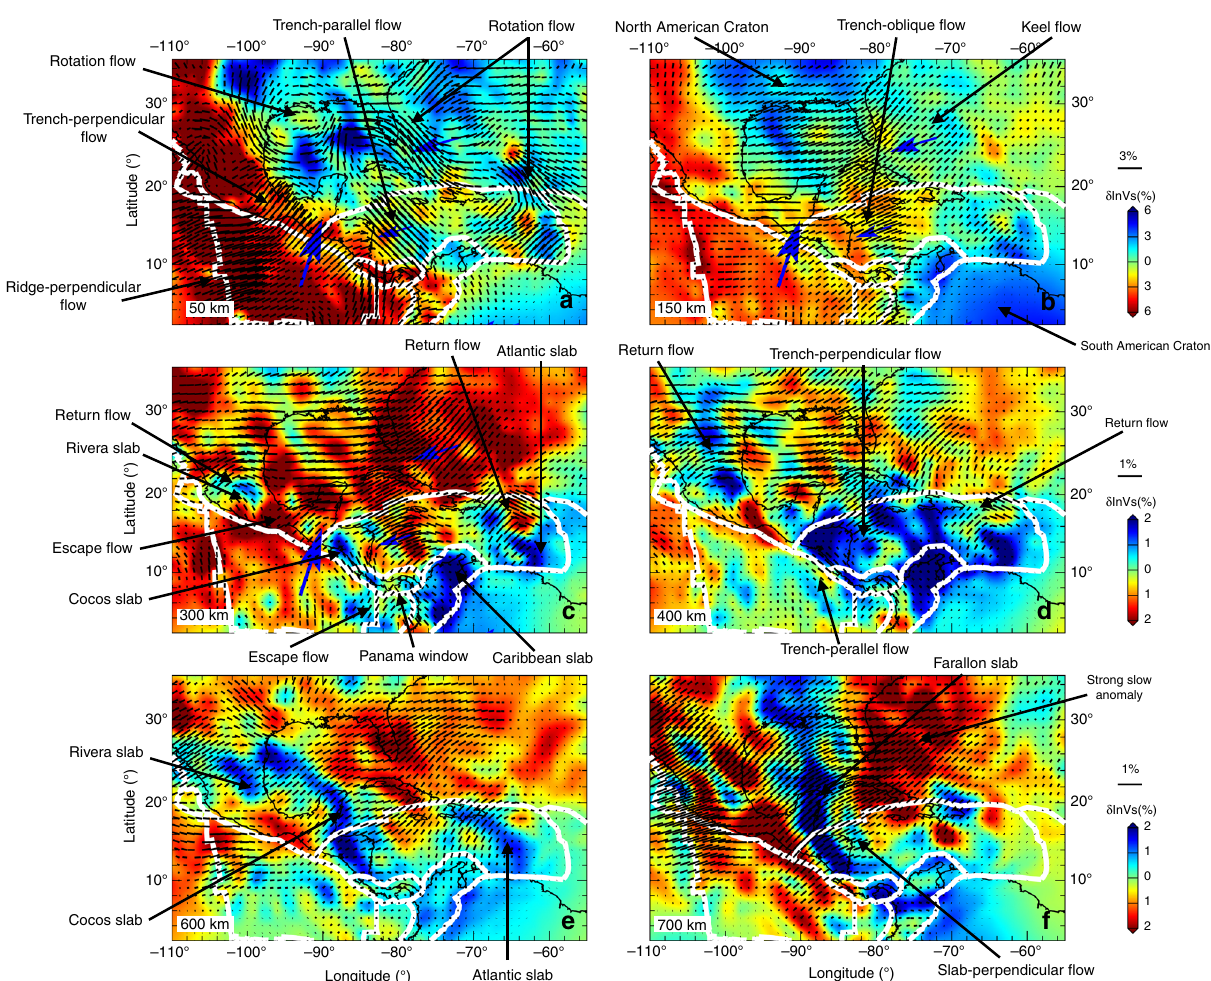
Fig. 5 Horizontal cross sections of relative perturbations in isotropic shear wavespeed and azimuthal anisotropy in model US 32 . a – f Results at depths ranging from 50 to 700 km. 1D reference model STW105 89 is used to calculate the relative wavespeed perturbations. The direction and magnitude of the fast axes are given by the orientation and length of the black bars. Key features discussed in the main text are highlighted by arrows , and white lines denote global plate boundaries 87 . Blue arrows at depths ranging from 50 to 300 km denote plate motion directions 58